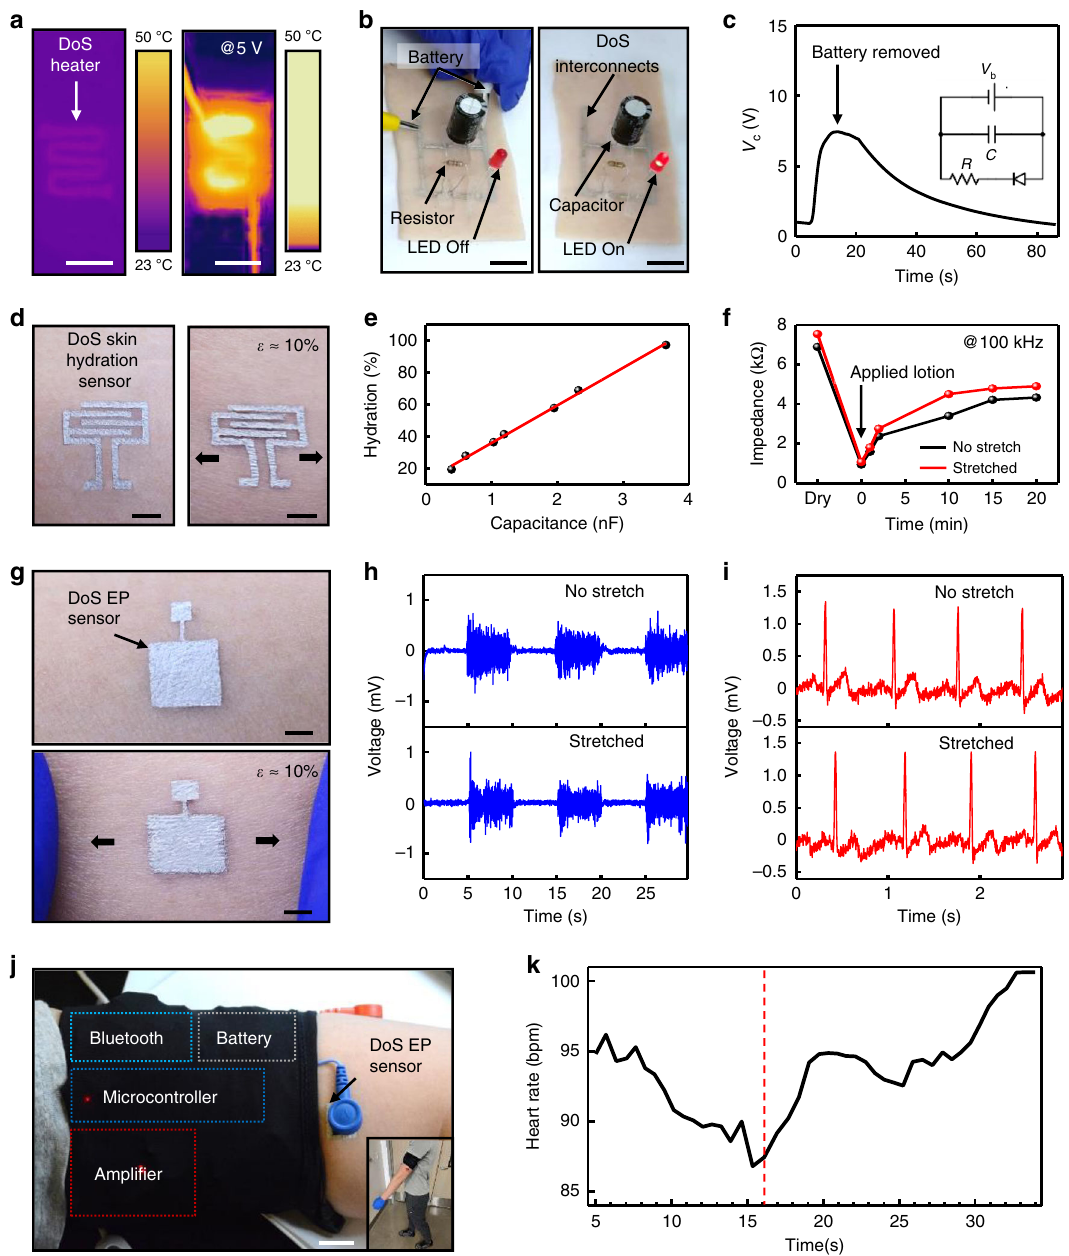
Fig. 3 DoS electronics on skin and wireless sensing. a IR camera images of the DoS heater on skin without applied voltage (left) and with an applied voltage of 5 V (right, scale bars 1 cm). b Ag-PEDOT:PSS ink serving as the interconnection during charging of a capacitor (left) and discharging through the resistor and LED (right, scale bars 2 cm). c Voltage of the capacitor showing charging until the battery is removed and then discharging afterwards. Inset is the circuit diagram showing a battery connected to a capacitor, which is connected to a resistor and LED that are connected in series. d DoS skin hydration sensor on skin without (left) and with applied strain (right, scale bars 2 mm). e Calibration of the DoS skin hydration sensor using a commercial hydration meter. f Impedance of the DoS skin hydration sensor without and with mechanical stretch. The arrow indicates the time at which lotion was applied to the dry skin. g DoS EP sensors without (top) and with applied strain (bottom, scale bars 2 mm). h Recorded EMG signals without (top) and with applied strain (bottom). i Recorded ECG signals without (top) and with mechanical stretch (bottom). j Schematic of the wireless transmission circuit components mounted on the arm and interface with the DoS EP sensors (scale bar 2 cm). k Average beats/min over all trials derived from the ECG signals attained with the DoS EP sensors. In the time prior to the red dashed line, the subject was standing still. After the red dashed line, the subject began